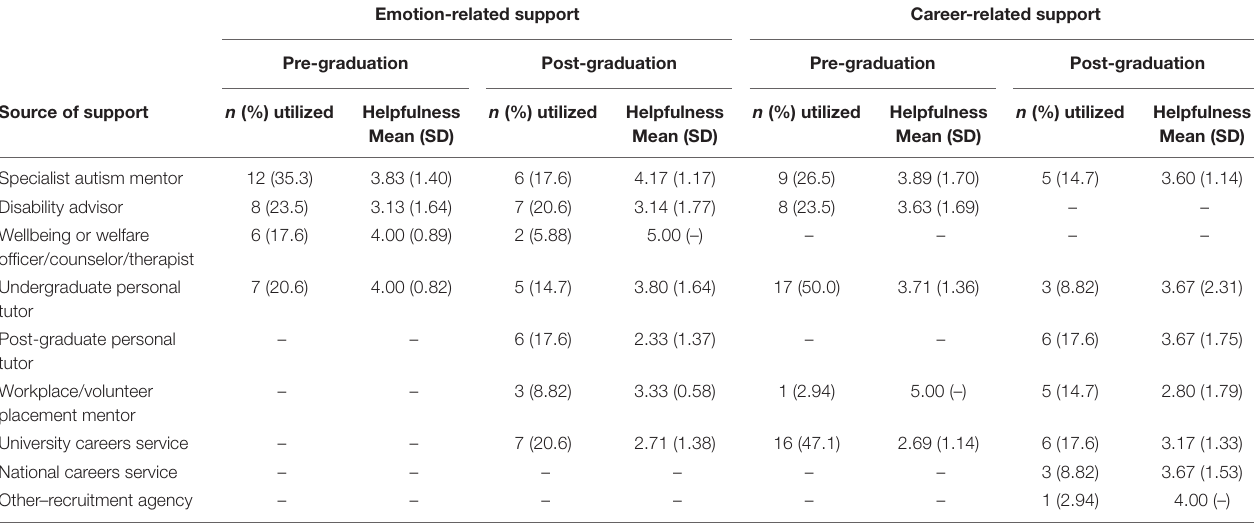
TABLE 2 | Participants’ use and perception of emotion-related transition support and career-related transition support, pre- and